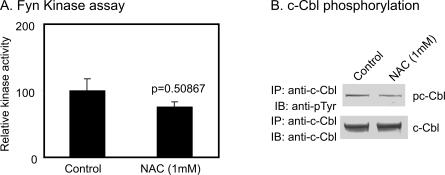
Exposure of O-2A/OPCs to 1 mM NAC Has Only Minimal Effects on Basal Activity of Fyn or Phosphorylation of c-CblAssays of Fyn activity and c-Cbl phosphorylation were carried out as in Figure 5, except that cells were exposed only to NAC and not to MeHg.(A) Basal Fyn activity is slightly, but not significantly, lower in cells exposed to NAC.(B) The extent of c-Cbl phosphorylation in O-2A/OPCs exposed to NAC is similar to that seen in cells grown in the presence of PDGF only. IB = immunoblot; IP = immunoprecipitation